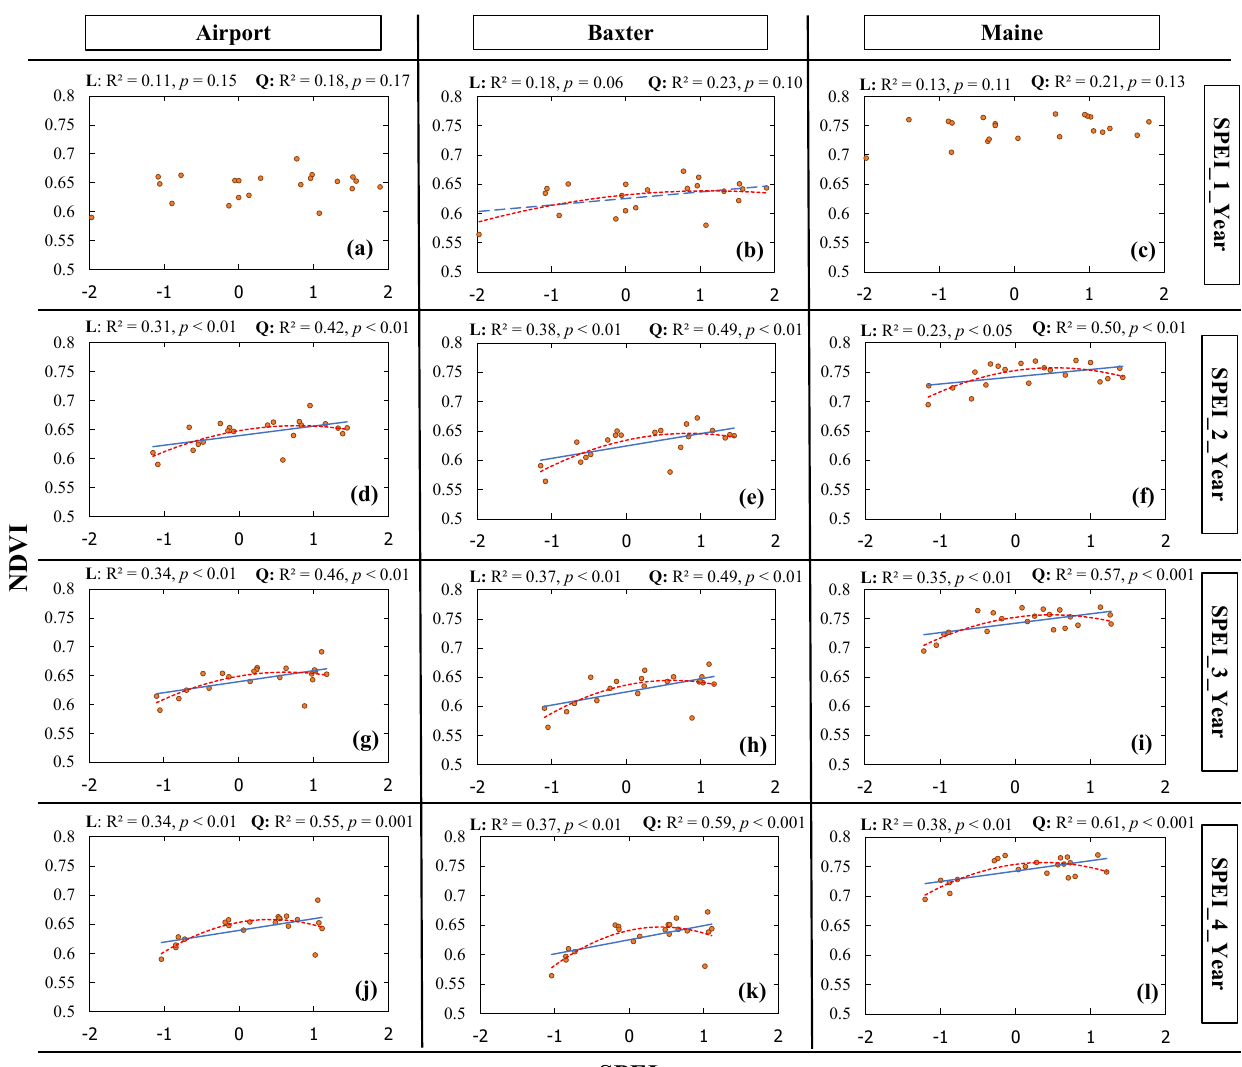
Figure 7. Average normalized difference vegetation index (NDVI) of wild blueberry fields during the growing season (May to Sep- tember) for three different study zones: Airport (irrigated), Baxter (non-irrigated), and the major wild blueberry production region in Maine in relation to ( a – c ) SPEI_1_Year; ( d – f ) SPEI_2_Years (average SPEI of two consecutive years); ( g – i ) SPEI_3_Years (average SPEI of three consecutive years); ( j – l ) SPEI_4_Years (average SPEI of four consecutive years). Here, SPEI refers to SPEI_6 of September and it represents the SPEI (water conditions) of the growing season (April–September). A positive SPEI value represents wet condi- tions, whereas a negative SPEI value indicates dry conditions. The blue solid lines indicate significant ( p < 0.05) and blue dashed lines indicate marginally significant ( p < 0.10) linear relationships. The dashed red lines indicate significant ( p < 0.05) or marginally signif- icant ( p < 0.10) quadratic relationships. The time period of the EVI and SPEI data was from 2000 to 2020.